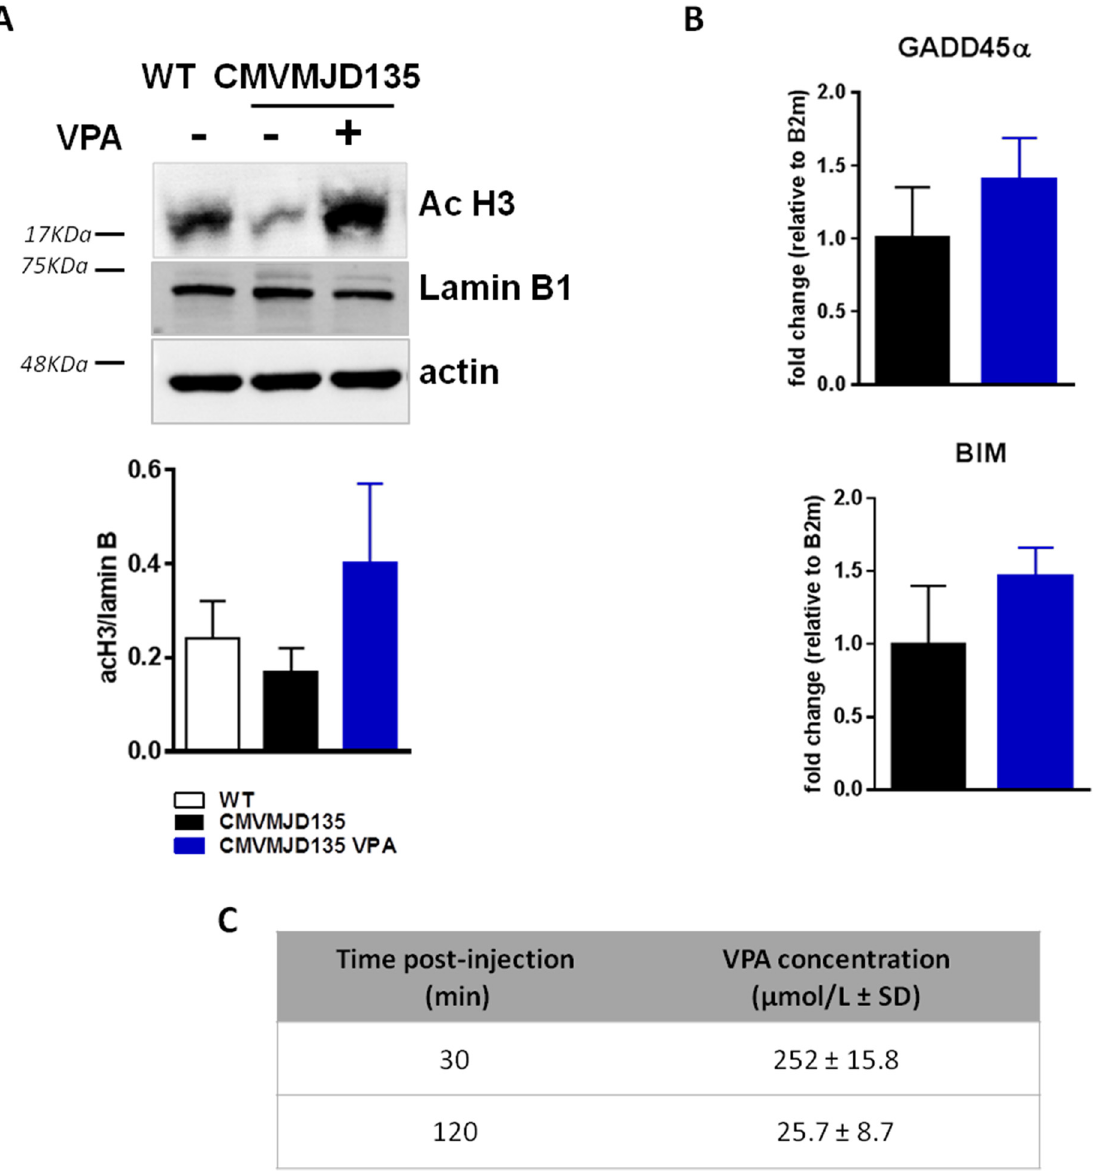
Fig 1. VPA acute treatment effects in cerebellum of CMVMJD135 mouse model. (A) A trend towards an increase in the H3 histone acetylation upon VPA acute treatment; (B) a trend towards an increase in GADD45 α and BIM mRNA levels upon VPA acute treatment and (C) VPA concentration in the plasma after 30 and 120 minutes post-injection. Bars represent the mean ± SEM (n = 4 males for each group), One-Way ANOVA.